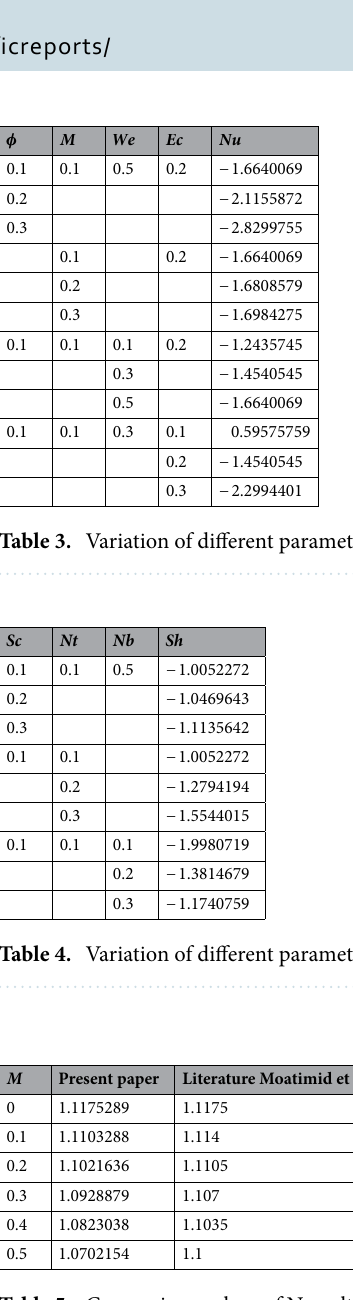
Table 5. Comparison values of Nusselt number with Literature 27